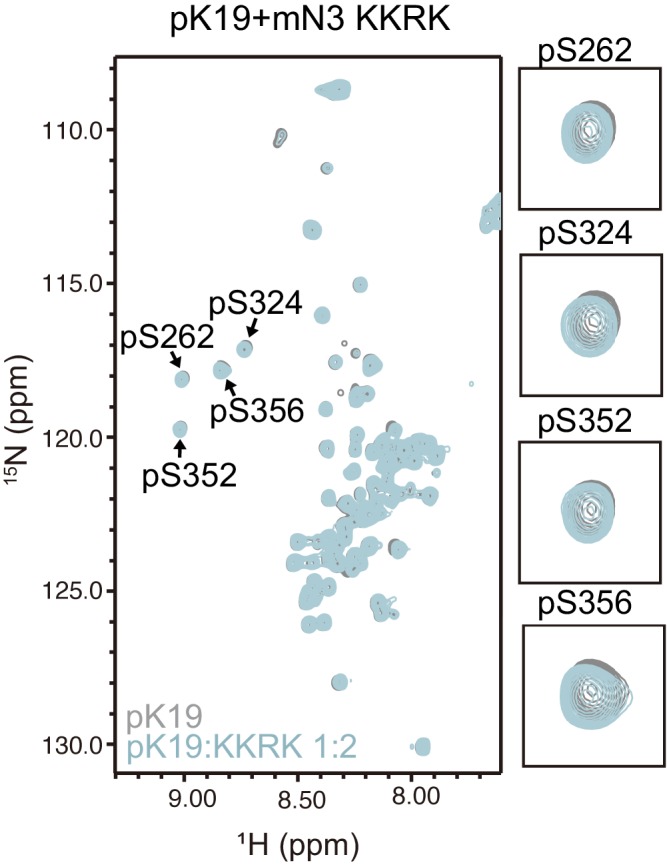
2D 1H-15N HSQC spectra of pK19 titrated by mN3-KKRK.pK19: 100 μM, gray; pK19 titrated by mN3-KKRK: molar ratio of 1:2, light blue. Signals of pSer residues are enlarged.